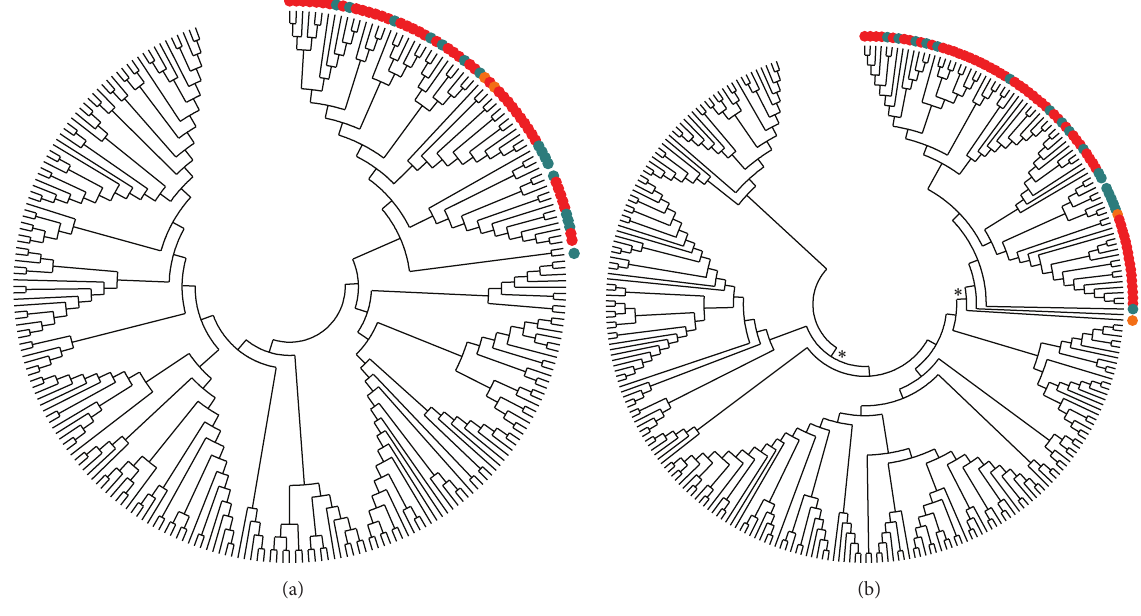
Figure 2: Cladogram of (a) the wHTH and (b) AAT domains of the MocR from RegPrecise and SynTax databanks. The cladograms have been calculated with the UPGMA method applied to multiple alignments of domain sequences filtered at 90% sequence identity. Pairwise distances between sequences were calculated in units of number of amino acid differences. The bootstrap tree was inferred from 1000 replicates. Domains from the YczR predicted to be linked to the YczE genes are denoted by green (Actinobacteria), orange (Gammaproteobacteria), and black (Alphaproteobacteria) dots. Red dots denote the YczR SynTax set. Other taxa are from non-YczE MocRs. Asterisks denote nodes supported by at least 90% bootstrap